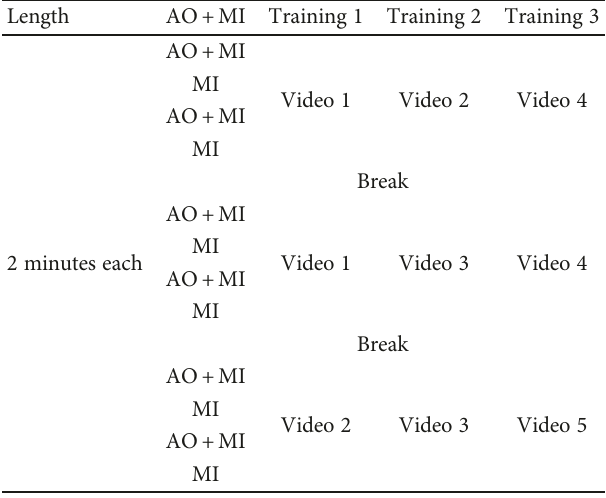
Table 2: Example of cognitive training intervention blocks for three successive trainings.